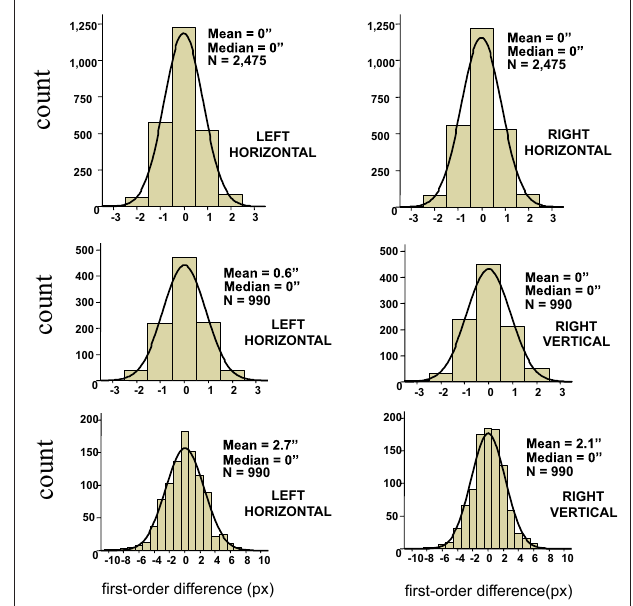
Figure 4 | Histograms of first-order differences for ping-pong adjustments of line segments’ lengths. The data are shown for a single participant in three experiments: with two short horizontal lines on the left and on the right (top panel), and with a horizontal line on the left and a vertical line on the right (middle panel for short lines, bottom panel for longer lines). The abscissae are calibrated in screen pixels (1 px ≈ 55 sec arc). The means and medians are shown in sec arc. See the opening text of this section and Dzhafarov (2006b) for details.